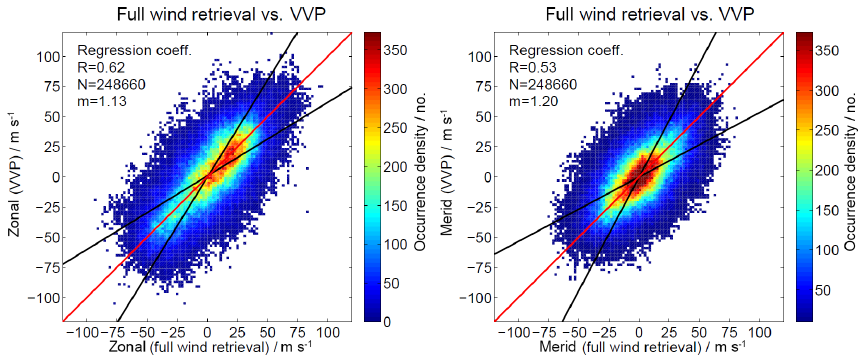
Figure 14. Comparison of zonal and meridional winds as derived from the new retrieval algorithm and the estimates for each grid point applying VVP.